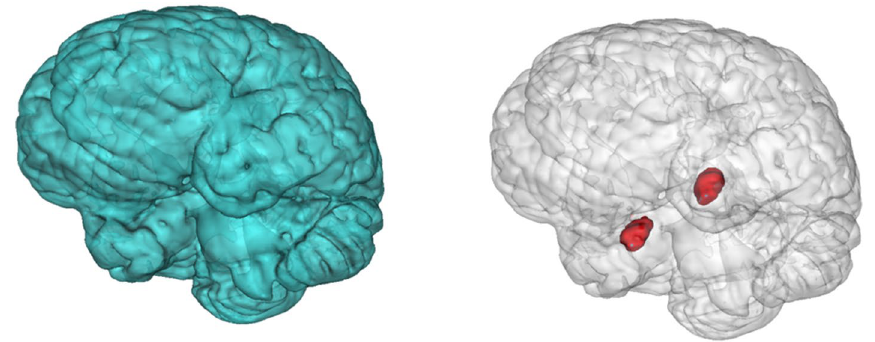
Figure 3. T1-weighted MRI scan showing the total brain (in blue) and amygdala (in red).